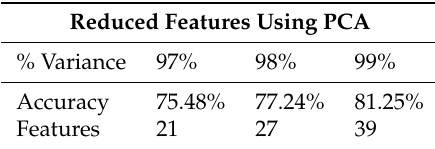
Table 7. Feature selection using principal component analysis